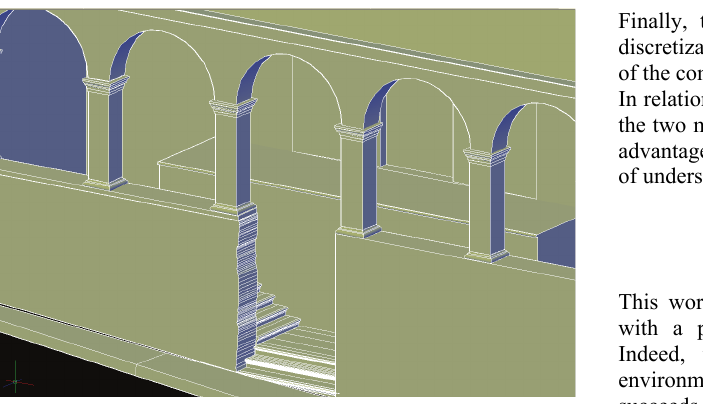
Figure 18. View of the porch geometric model